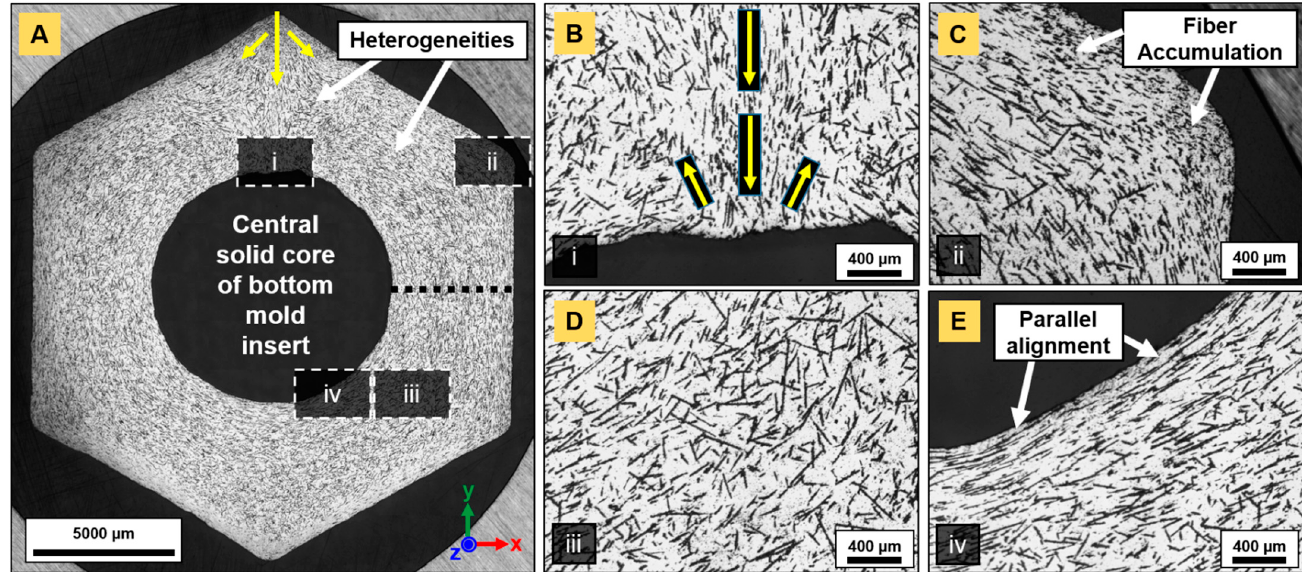
Figure 7. Optical micrographs showing fiber dispersion and orientation in the (x,y) plane in a PBS1200 nut reinforced with 20 vol.% N720 aluminosilicate fibers: ( A ) reconstructed image from ~140 overlapped tiles and fiber orientation in ( B ) the area opposite the mold gate, ( C ) at corners, ( D ) in bulk and ( E ) along thread. The dotted black line in ( A ) is an indication of Figure 10.